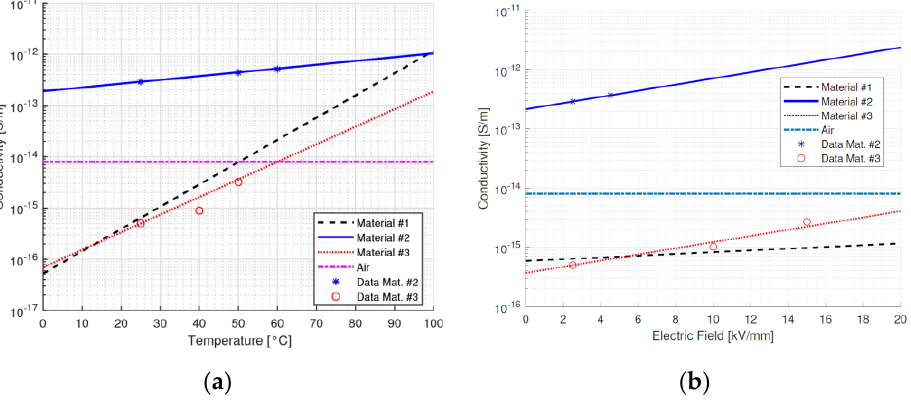
Figure 4. Bulk conductivity for materials #1 to #3 and air as a function of ( a ) temperature at field E = 2.5 kV/mm and ( b ) electric field at T = 25 °C. Table 2. Material parameter for different insulator materials @ 25 °C.